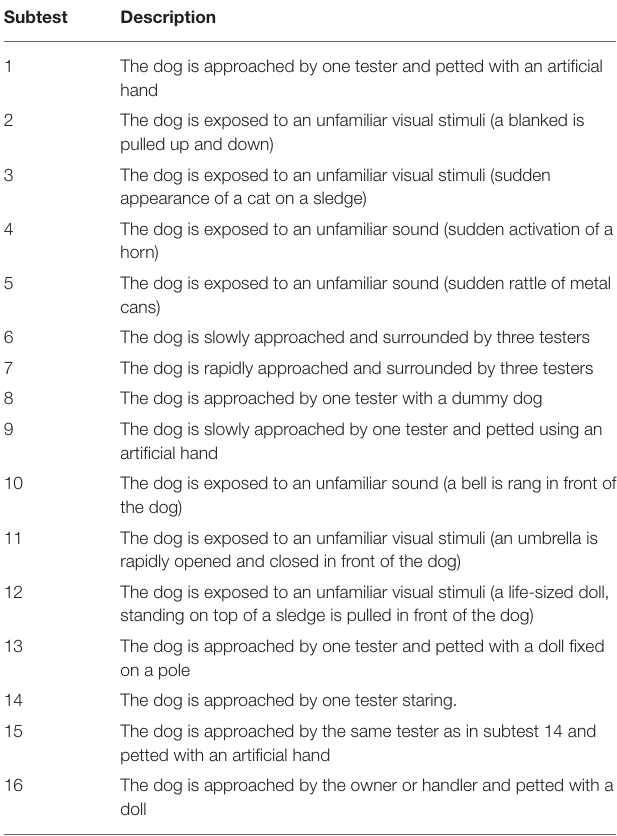
TABLE 1 | Descriptions of 16 socially acceptable behavior subtests from Gobbo and Zupan Šemrov